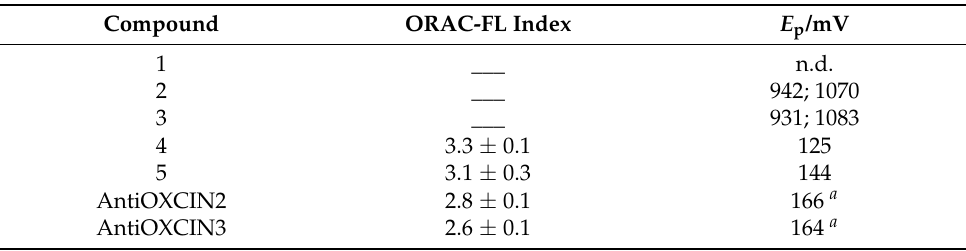
Table 4. ORAC-FL indexes and redox potentials ( E p ) of piperine (compound 1), compounds 2–5, AntiOXCIN2 and